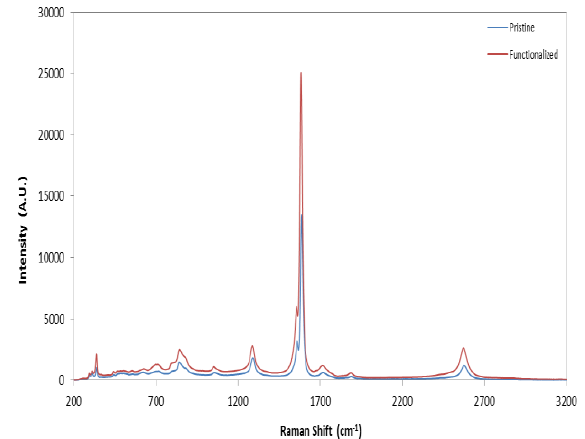
Figure 8. Raman spectrum of pristine and + 2Zn2 hydrazone-functionalized HiPco SWCNTs. The spectrum of the + 2Zn2 hydrazone-functionalized film appears to have been down shifted compared to the pristine film.